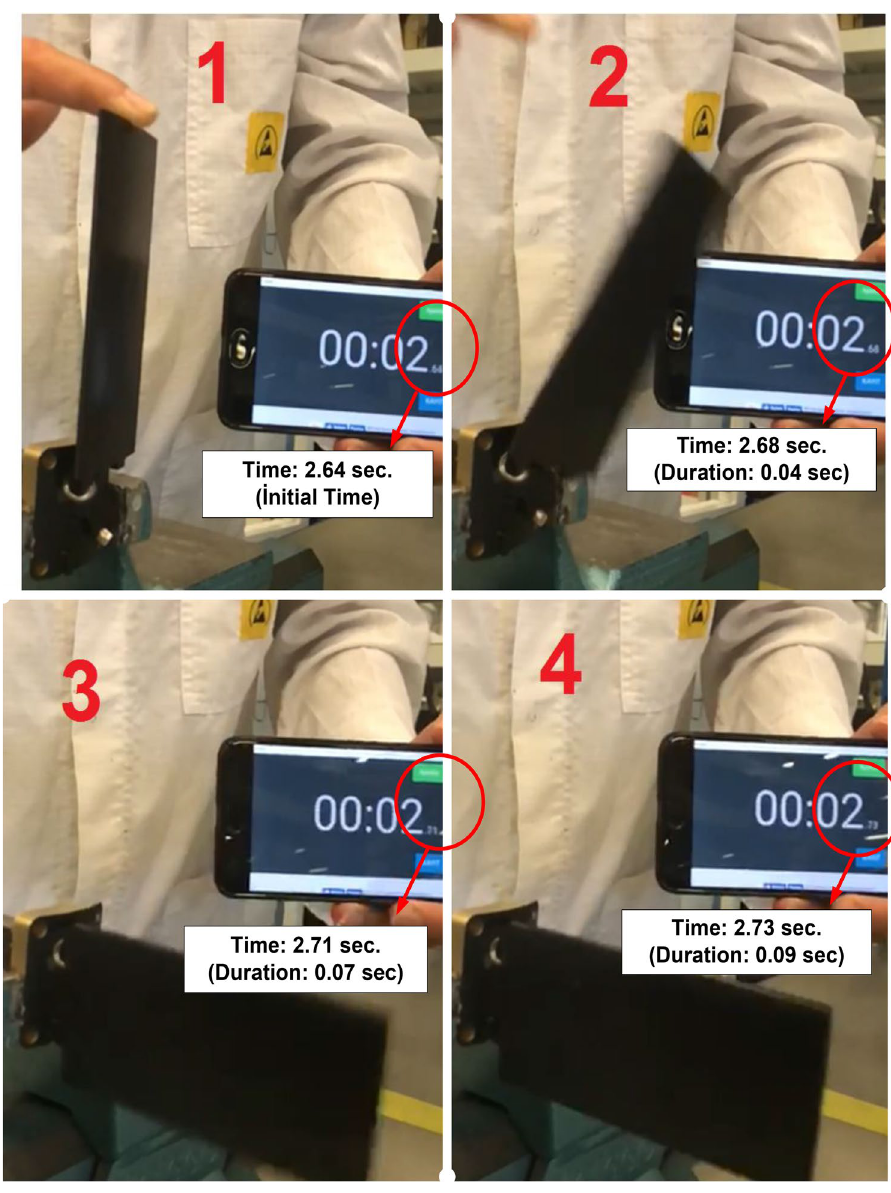
Figure 8. Prototype test for deployment time analysis of foldable wing